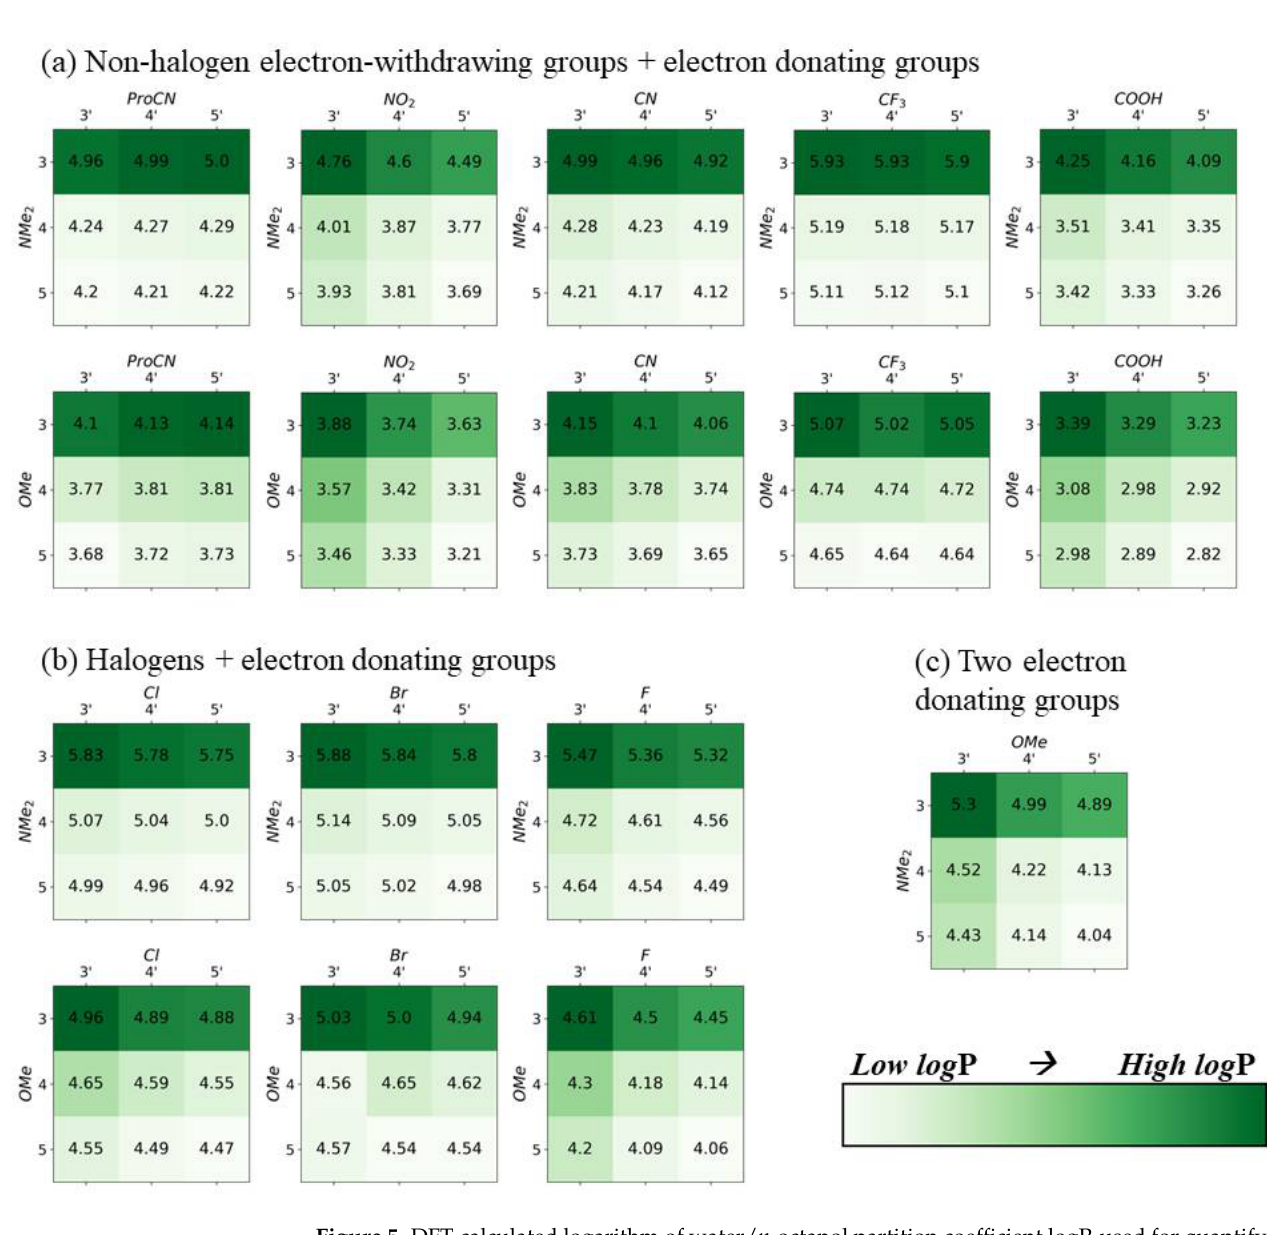
Figure 5. DFT-calculated logarithm of water/ n -octanol partition coefficient logP, used for quantifying hydrophobicity for all opposite-side substituent pairs. Darker green indicates a larger logP. The ground-state geometry, optimized in vacuum, was used for all calculations. Darker colors indicate higher values. The color range is only consistent for each substituent pair, and color-coding should not be used to compare values between pairs.